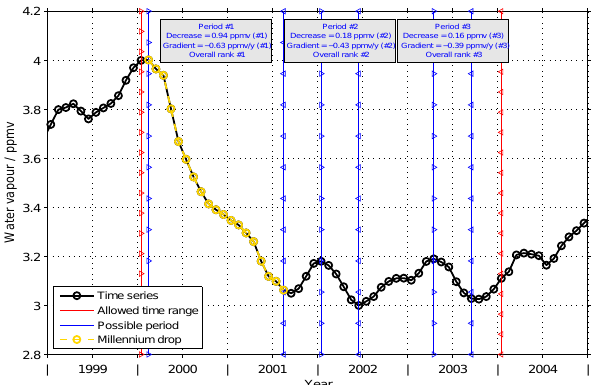
Figure A1. An example of the millennium drop (phase 1) char- acteristics analysis considering the HALOE/MIPAS time series at 100hPa at the Equator. The time series is given in black and rep- resents a running mean over 1 year. The red lines indicate the gen- eral time interval where a water vapour decline will be considered. Within this period three periods can be found where water vapour is decreasing. The first period from February 2000 to August 2001 (overplotted in yellow) exhibits both the largest decrease and abso- lute gradient and is therefore selected as the representative period for the millennium drop (phase